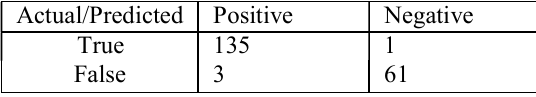
Table 2. CONFUSION MATRIX OF SVM ALGORITHM